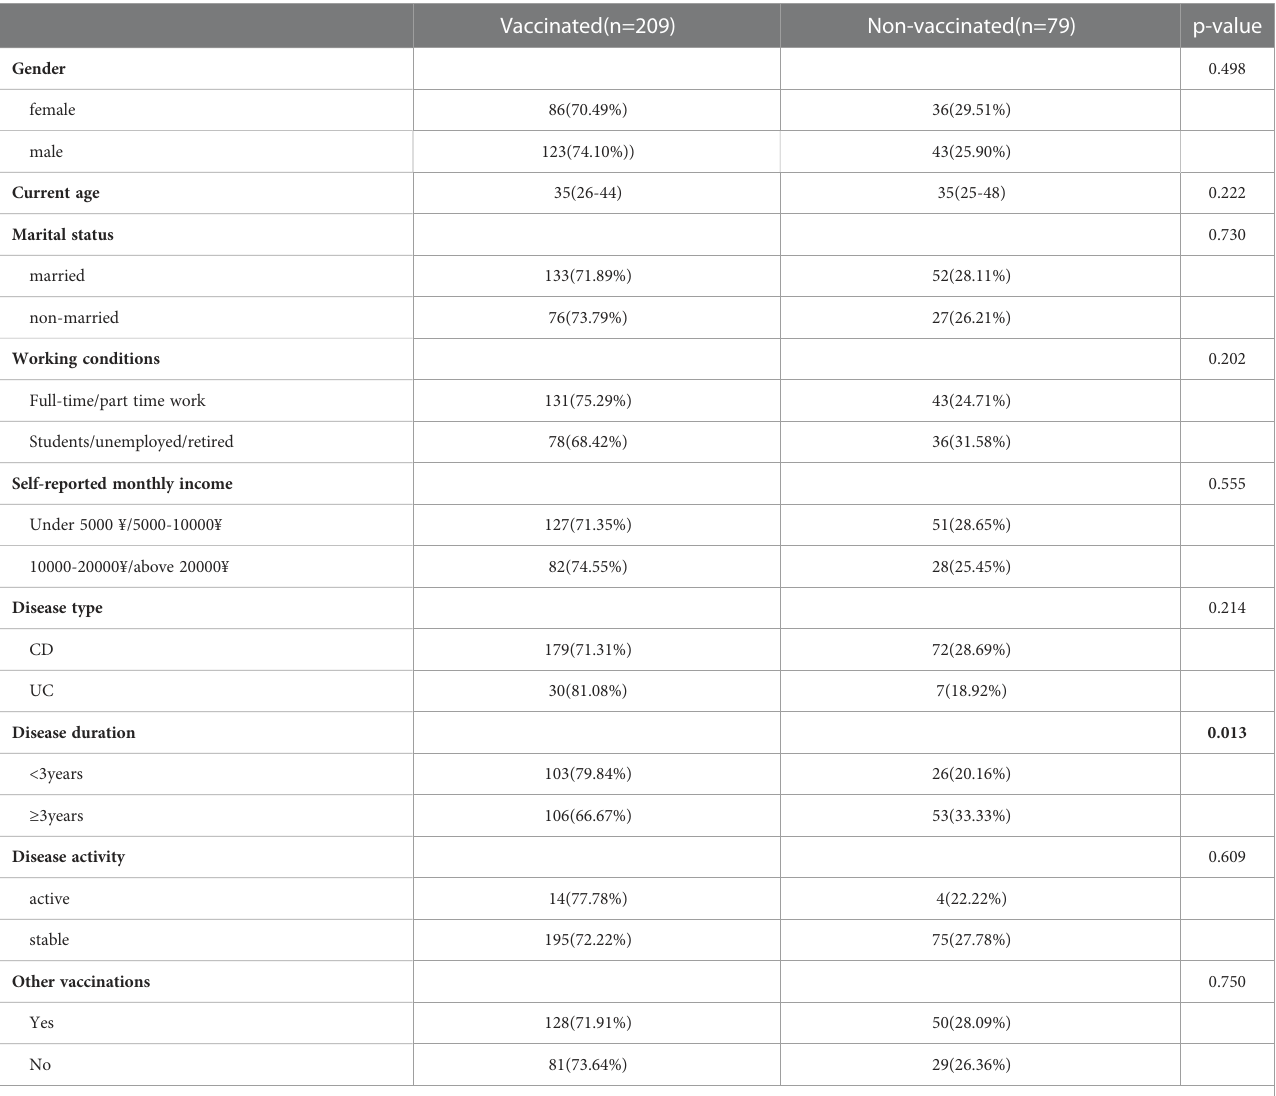
TABLE 3 Factors on socioeconomic characteristics (univariate